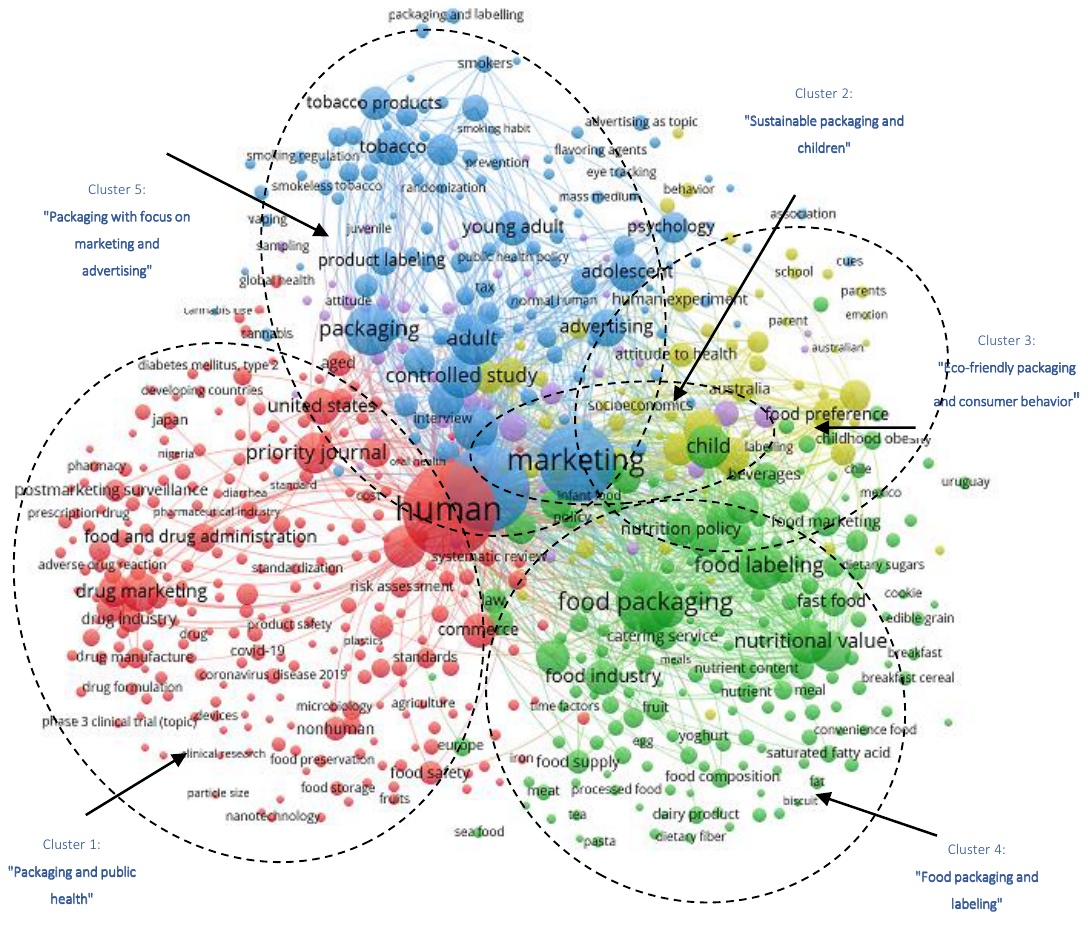
Figure 5. Main research clusters of safe packaging Table 2. The results revealed five main themes of the study in particular (Figure 5):